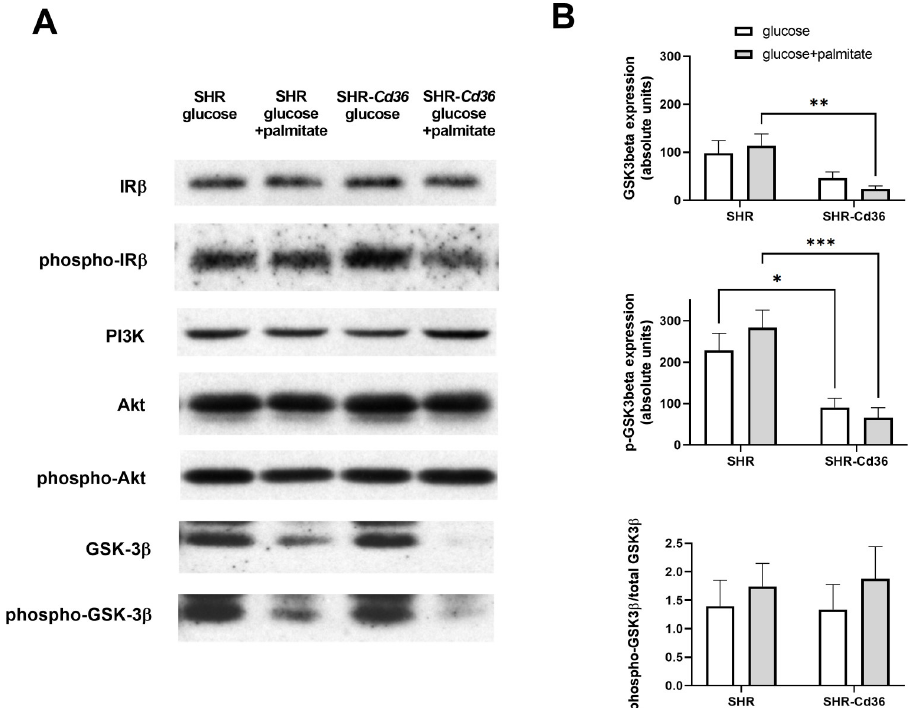
Fig 2. Effect of Cd36 on expression and phosphorylation of key components of the insulin signalling pathway. Samples of BAT isolated from SHR and SHR- Cd36 were incubated in Krebs-Ringer bicarbonate buffer with glucose alone or together with palmitate, then homogenised and subjected to gel electrophoresis and Western blotting as described in Methods. Immunoblots shown are representative of six experiments (A). Signal intensities corresponding to detected proteins were quantified by densitometric analysis and normalised to total protein determined by Ponceau staining (B). * , ** , and *** denote P < 0.05, P < 0.01, and P < 0.001 significant differences.